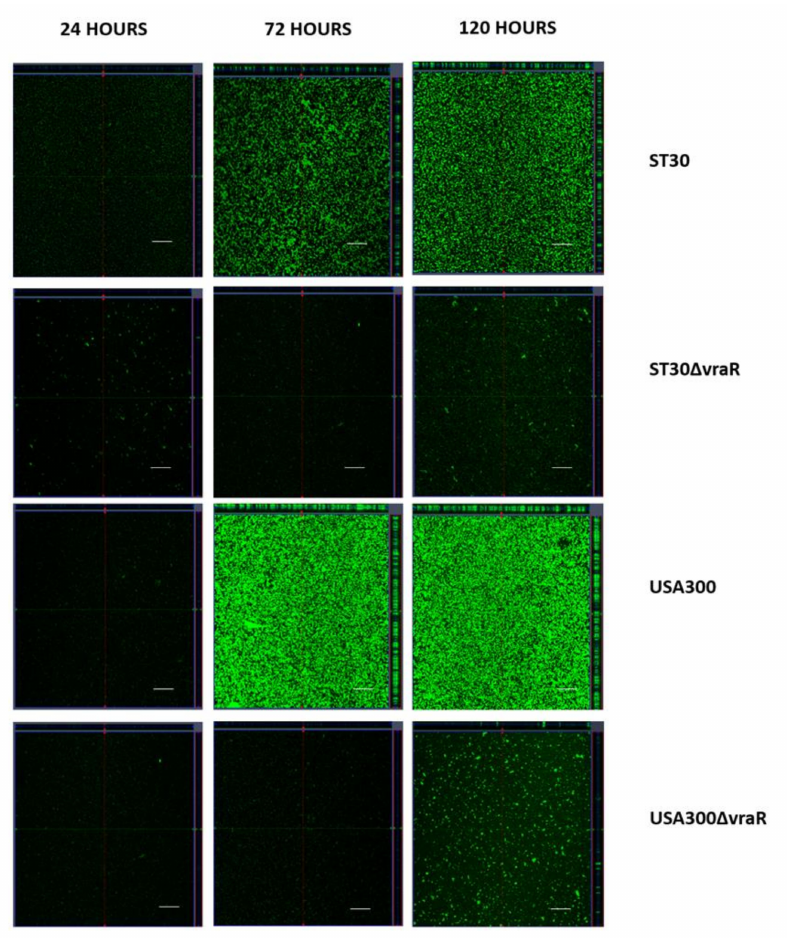
Figure 8. USA300 and their isogenic mutants ST30 ∆ vraR and USA300 ∆ vraR. The central panels rep- resent the x–y plane, and the top and right side panels represent the x–z and y–z planes, respectively. Scale bars represent 50 µ